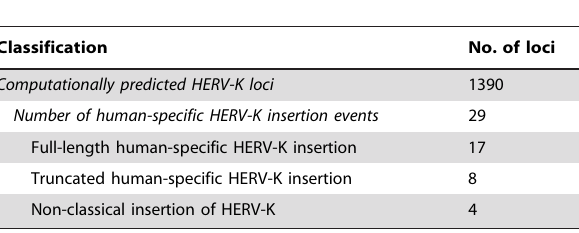
Table 1. Summary of human-specific HERV-K